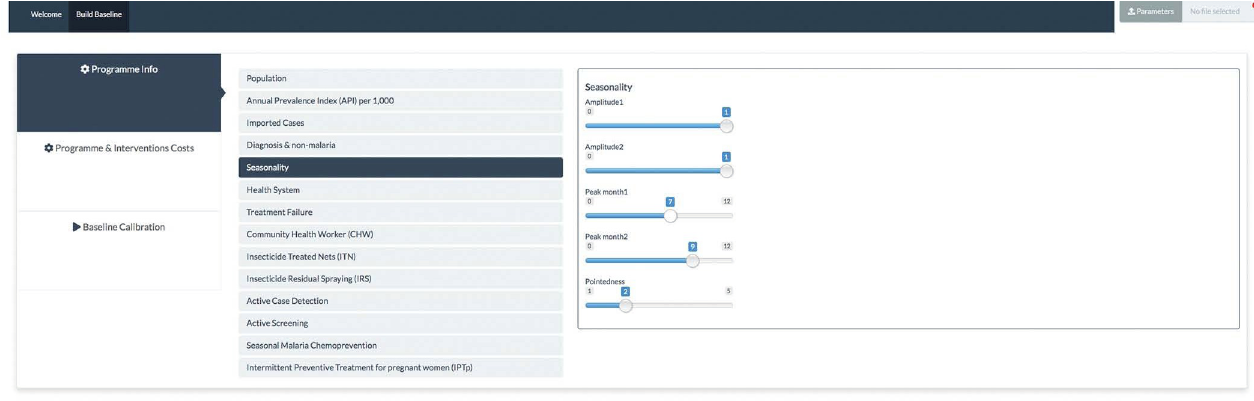
Fig 6. Changes to input sliders for amplitude parameters of the Transitional forest and Coastal savannah model codes.